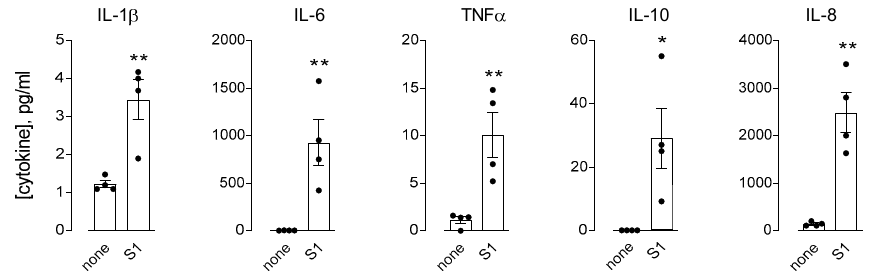
Figure 4. MDM were incubated for 16 h in the absence (none) or in the presence of 10 nM of SARS- CoV-2 spike protein supplemented with 2 µg/mL Polymyxin B (S1). The amount of the indicated cytokines was measured with an ELISA assay, as described in Materials and Methods. Data are means ± SEM of four independent determinations, each represented by the different dots. * p < 0.05, ** p < 0.01 vs. none, with a two-tailed Student’s t -test for unpaired data.